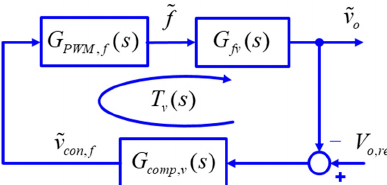
Figure 15. Control block diagram of the output voltage loop.